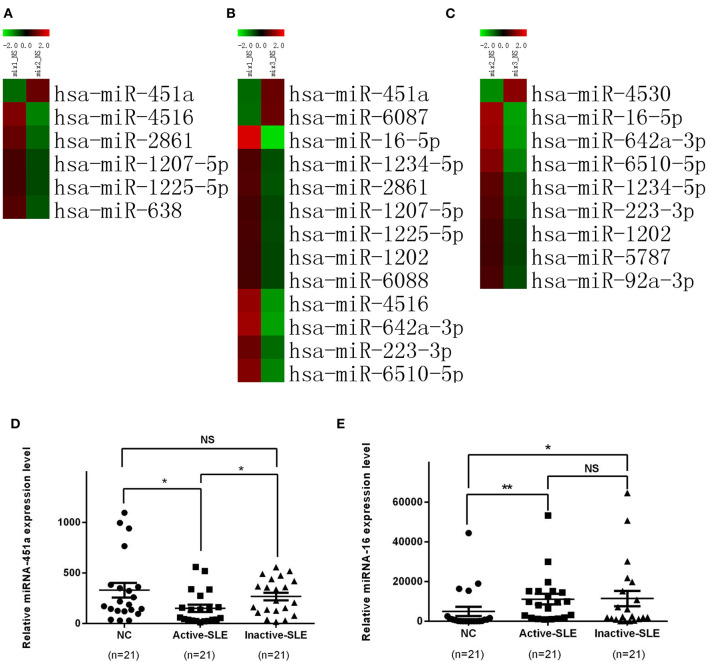
Significant differential expression of miRNAs in serum exosomes in patients with SLE and normal controls. (A) Heat map comparing active SLE and normal control groups. (B) Heat map comparing active and inactive SLE groups. (C) Heat map comparing inactive SLE and normal control groups. (D) The expression level of exosomal miR-451a in active SLE (n = 21) was lower than that in patients with inactive SLE (n = 21) and normal controls (n = 21), while the expression level of exosomal miR-451a in patients with inactive SLE and normal controls showed no differences. (E) The expression level of exosomal miR-16 in active SLE (n = 21) and inactive SLE (n = 21) was higher than that in normal controls (n = 21), but showed no significant difference between patients with active SLE and inactive SLE. RT-qPCR results were normalized to Cel-miR-39. *P < 0.05,**P < 0.01, NS, no significance.